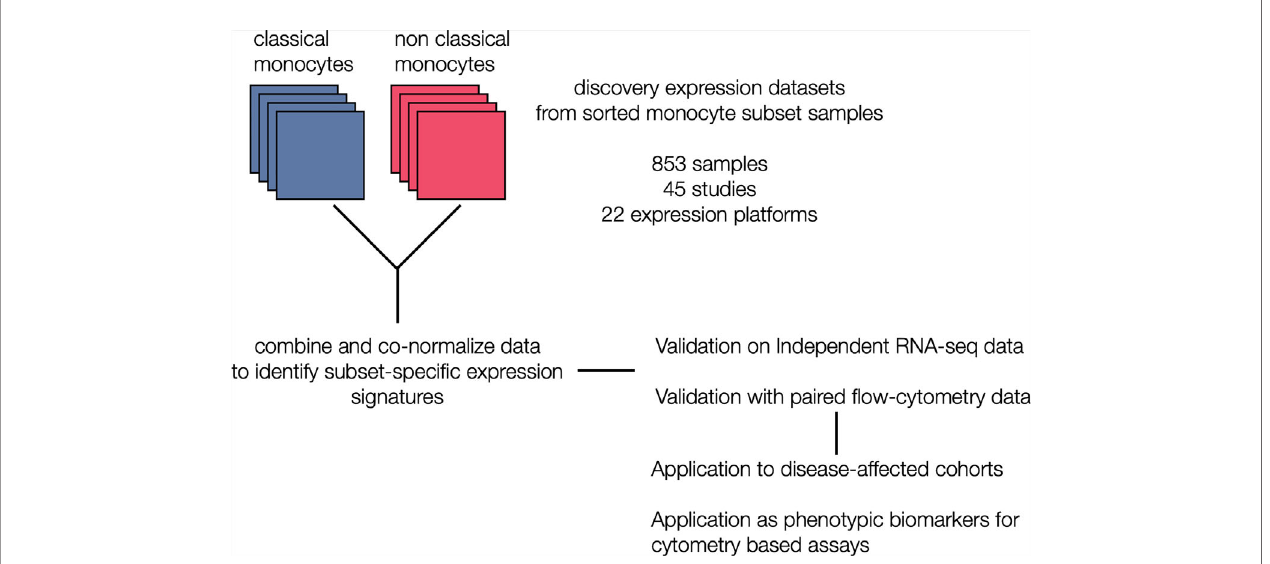
FIGURE 1 | Generation of monocyte-speci fi c signatures: Work fl ow depicting collection and annotation of publicly available discovery datasets from NCBI GEO pro fi ling sorted human monocyte cell subsets (classical and non classical). Data was the combined and co-normalized to identify subset-speci fi c signatures. Signatures were validated on a independent RNA-seq chohort, and on PBMCs expression pro fi les with paired fl ow data. After validation, signatures were applied on disease-affected cohorts and tested for their viability as phenotypic markers in cytometry-based